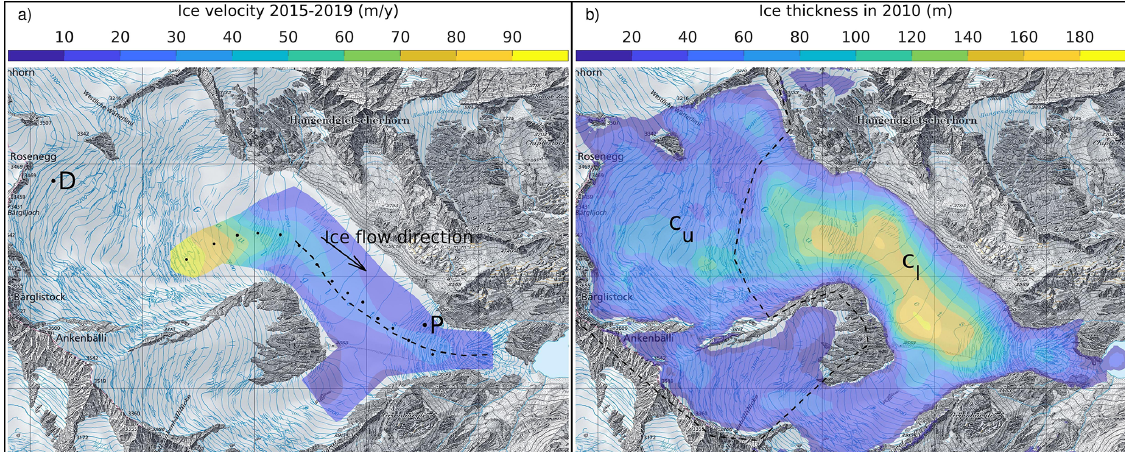
Figure 3. Topographic map of Gauligletscher with 1km grid spacing showing (a) the observed surface velocities over the period 2015–2019 derived by remote sensing (Appendix A) and (b) ice thickness distribution in 2010. In panel (a) , the dashed line shows the line of maximal observed velocities along each lateral transect, while the dots indicate the position where the observed modeled RMSE is computed. The location where the Dakota airplane crash-landed in 1946 and the place where pieces of the plane were released in 2018 at the surface are indicated by the letters “D” and “P”, respectively. In panel (b) , the dashed line delimits the lower and upper glacier areas where sliding is parametrized with c l and c u , respectively. Reproduced by permission of swisstopo